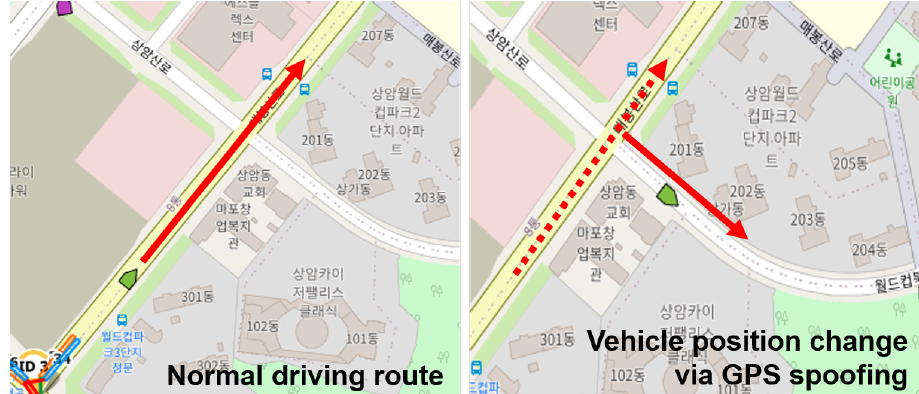
Figure 11. This figure shows a GPS spoofing scenario in which the GPS values are changed using the same address and ID in a vehicle node driving usually. The third vehicle perceives that the GPS information of the vehicle, with the pertinent ID, changes continuously, as shown in the